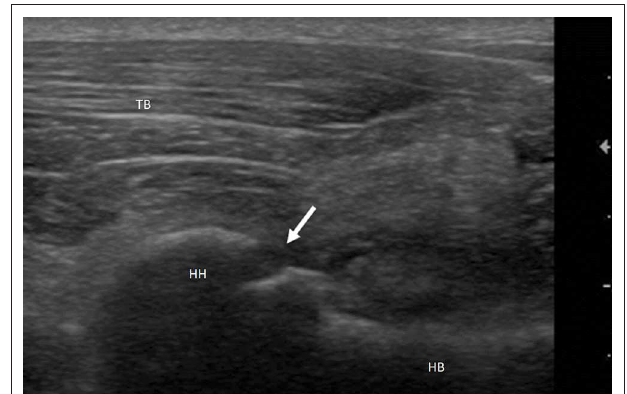
FIGURE 1 | Mixed breed dog, male, 2yo. Shoulder arthropathy. Longitudinal scan of humeral head: caudal view. Interruption of the hyperechoic profile of the bone articular surface (arrow) suggestive of ostechondritis dissecans. HH, Humeral Head; HB, Humeral Body; TB, Triceps Brachii.